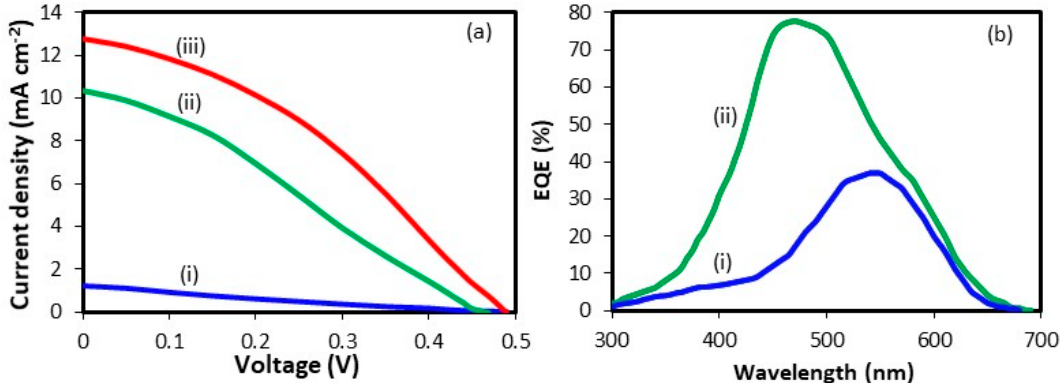
Figure 3. ( a ) Current density-voltage characteristics of (i) untreated and unannealed Ti/ n -Cu 2 O/ p